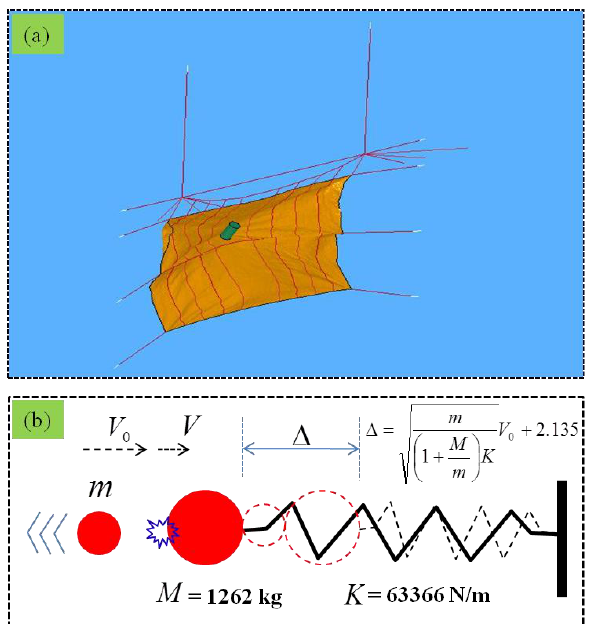
Figure 2. The FE-based nonlinear numerical model (a) and the Energy-Momentum based 2 Fig. 2. The FE based nonlinear numerical model (a) and the equivalently linear, lumped mass, single-degree-of-freedom (SDOF) analytical model with 3 Energy-Momentum based equivalently linear SDOF analytical model with the respective displacement-predictive correlation (b) of the respective displacement-predictive correlation (b) of the R-LPR structure, in deformed 4 the R-LPR structure, in deformed states. Due to the fine discretiza- states. Due to the fine discretization of the wire-net-equivalent shells in 50 mm x 50 mm grid 5 tion of the wire-net-equivalent shells in 50mm × 50mm grid cor- corresponding to the woven mesh size in reality, the individual finite elements are not seen in 6 responding to the woven mesh size in reality, the individual finite the FE model. It is noted that a mesh optimization study and/or a coupled modelling in the 7 elements are not seen in the FE model. It is noted that a mesh op- timization study and/or a coupled modelling in the future may save future may save some computational cost. See also Fig. 6. 8 some computational cost. See also Fig. 5.